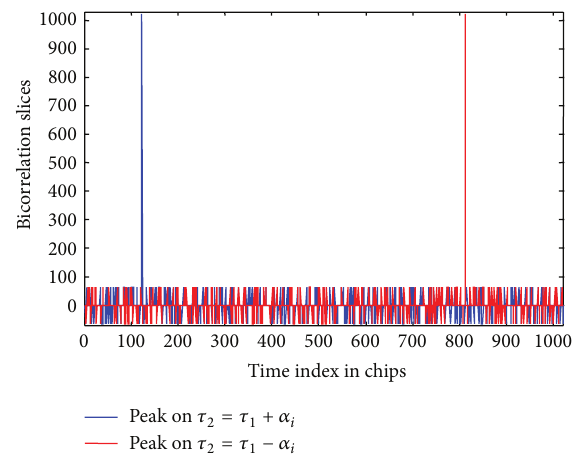
Figure5: Exampleofdetermining 𝛼 𝑖 fromthebicorrelation ofcodes 𝑖 = 26 and 𝑘 = 31